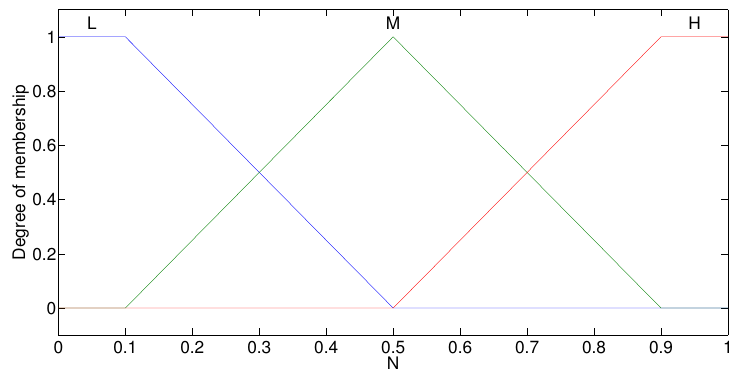
Figure 1. Membership functions of the fuzzy input N .